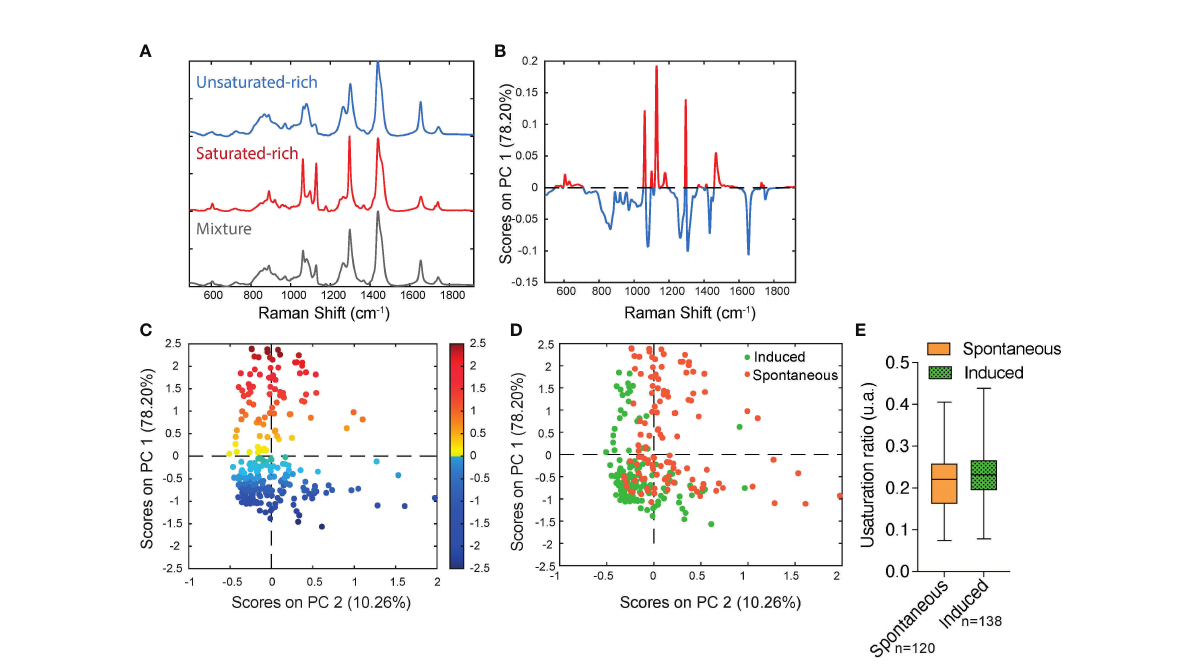
FIGURE 4 Raman microspectroscopy reveals predominance of unsaturated spectra in induced adipocytes, with heterogeneity in the unsaturation ratio for the spontaneous condition. (A) Representative Raman spectrum of saturated-rich, unsaturated-rich lipids and mixture identi fi ed by unguided hierarchical cluster analysis. (B) Loading plot PC1 indicates the discriminant peaks for saturated versus unsaturated designation, the color is associated to the attribution of speci fi c Raman bands: saturated in blue, unsaturated in red (n = 3 independent experiments, pooled for PCA analysis). (C) PCA score plot of Raman spectra labelled according to spontaneous (orange) and induced (green) OP9-adipocytes. (D) The same PCA score plot as (C) labelled according to the assignment of Raman spectra as saturated (red) and unsaturated (blue) lipids based on the PC1 loading determined by (B) For panels C and D, each point is a single adipocyte with all its lipid droplet data points averaged. n (induced) = 138 adipocytes, 2971 spectra; n (spontaneous) = 120 adipocytes, 2944 spectra. (E) Unsaturation ratios of spontaneous and induced at adipocyte level. The unsaturation ratio of sOP9 adipocytes is not different from iOP9 adipocytes (P = 0.0855 by Mann-Whitney